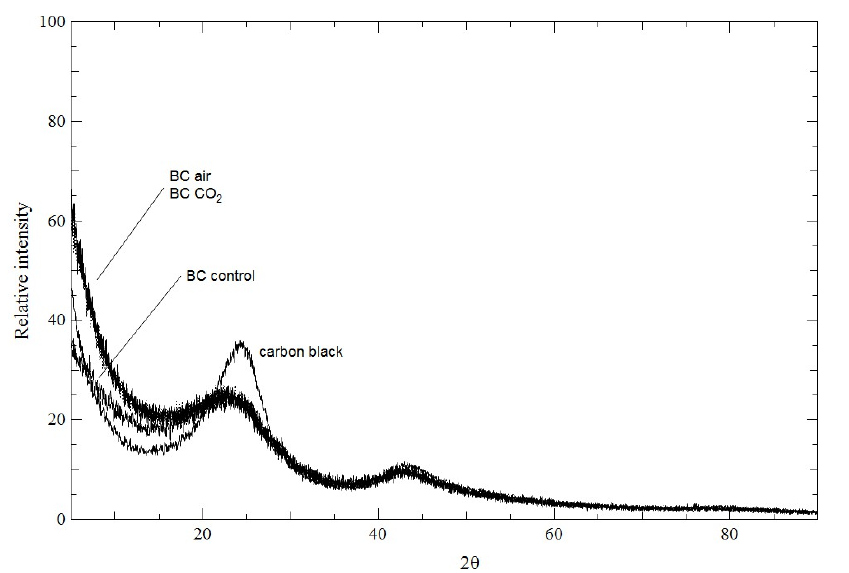
Figure 1. X-ray diffraction spectra of CB, biochar control, and gas-treated biochar samples. Graphitic d-spacing peaks at 24° and 43° 2 θ are typical of high carbon content materials such as CB and are seen in all four samples.